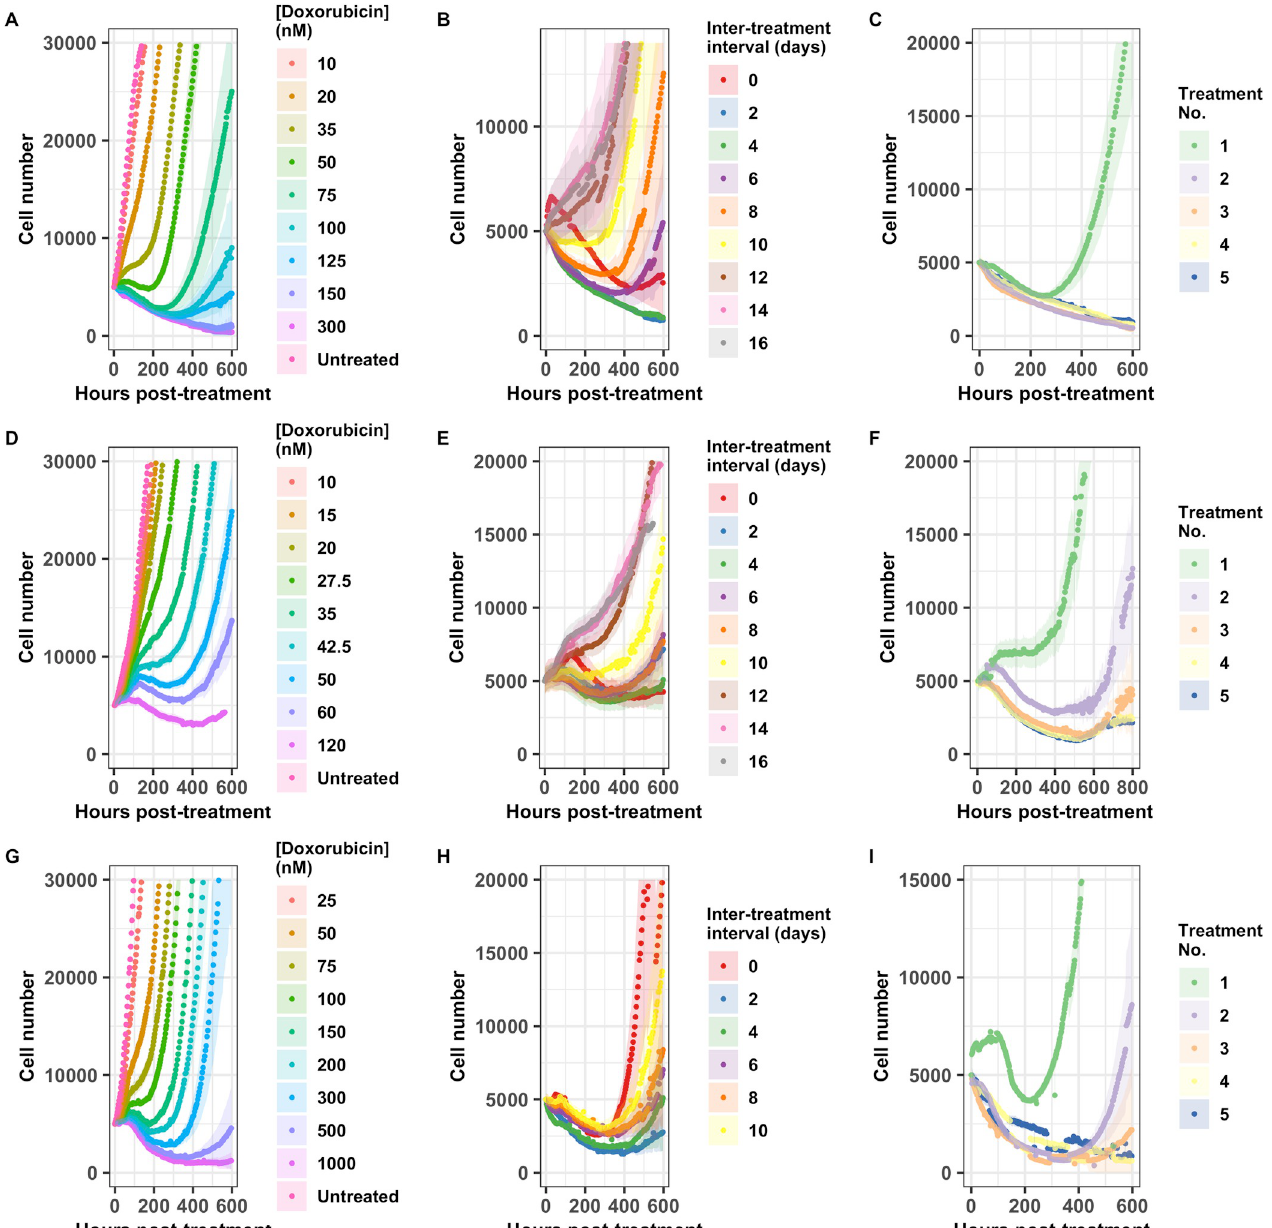
Fig 3. Cell population response to doxorubicin regimens. Population level response to 24 hour doxorubicin exposures is quantified as doxorubicin concentration varies in the MCF7 cell line (A), the BT474 cell line (D), and the MDA-MB-231 cell line (G), as the interval between two 24 hour doxorubicin exposures varies at 75 nM in the MCF7 cell line (B), at 35 nM in the BT474 cell line (E), and at 200 nM in the MDA-MB-231 cell line (H), and as the number of sequential 24 hour doxorubicin exposures varies at a two day interval and 75 nM in the MCF7 cell line (C), at a zero day interval (continuous exposure) and 35 nM in the BT474 cell line (F), and at a two day interval and 200 nM in the MDA-MB-231 cell line (I). Each curve represents the average of six (A, D, G) or 12 (B, C, E, F, H, I) replicate samples, and 95% confidence intervals are marked by the shaded regions. All curves are aligned such that t = 0 is the beginning of the final drug exposure for that treatment